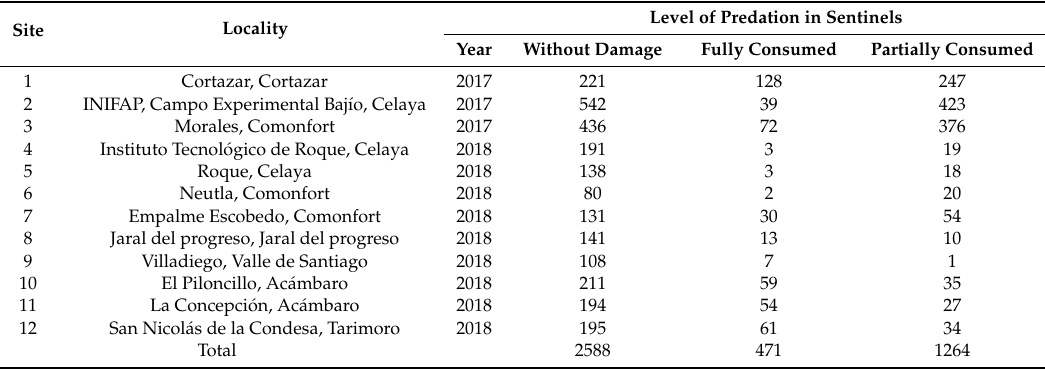
Table 1. Locality, municipality and quantity of recovered masses of Spodoptera frugiperda in Guanajuato, Mexico (spring–summer 2017–2018